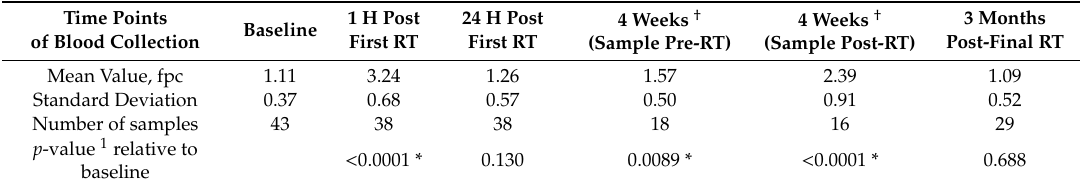
Table 1. Statistics of γ -H2AX foci per cell (fpc) values in peripheral blood mononuclear cells (PBMC) collected at di ff erent time points and fixed immediately after blood